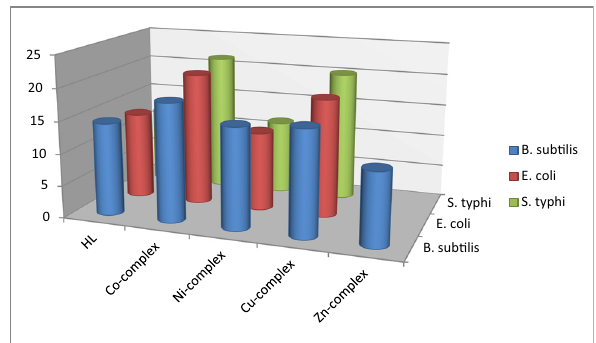
Figure 2: In vitro antibacterial activity of the ligand and its mixed - ligand